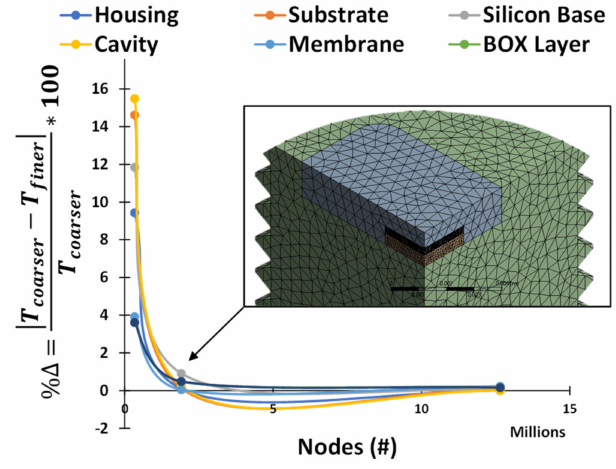
Figure 4. Grid-independence study results with the final selected